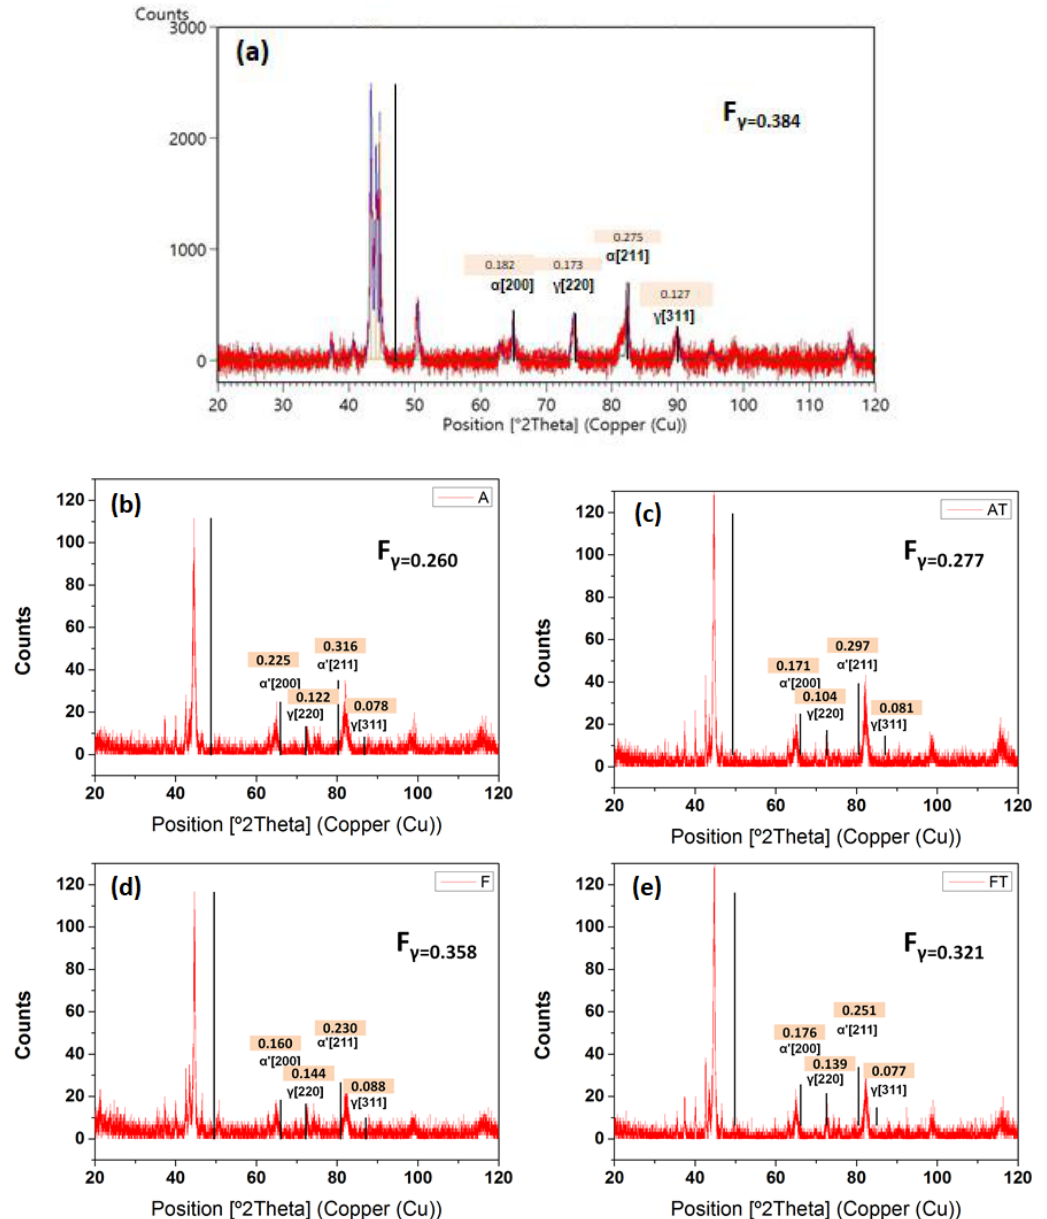
Figure 6. XRD spectrum of the post-heat-treated condition: ( a ) non–heat-treated M4 deposits: ( b ) A; ( c ) F; ( d ) AT; ( e ) FT.